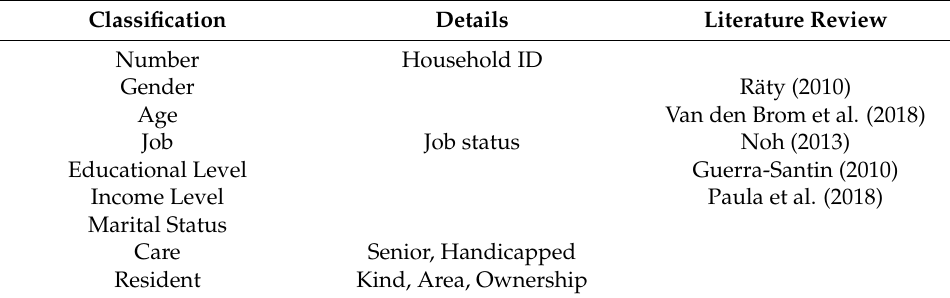
Table 1. Household information of the Korean Time-Using Survey [16].